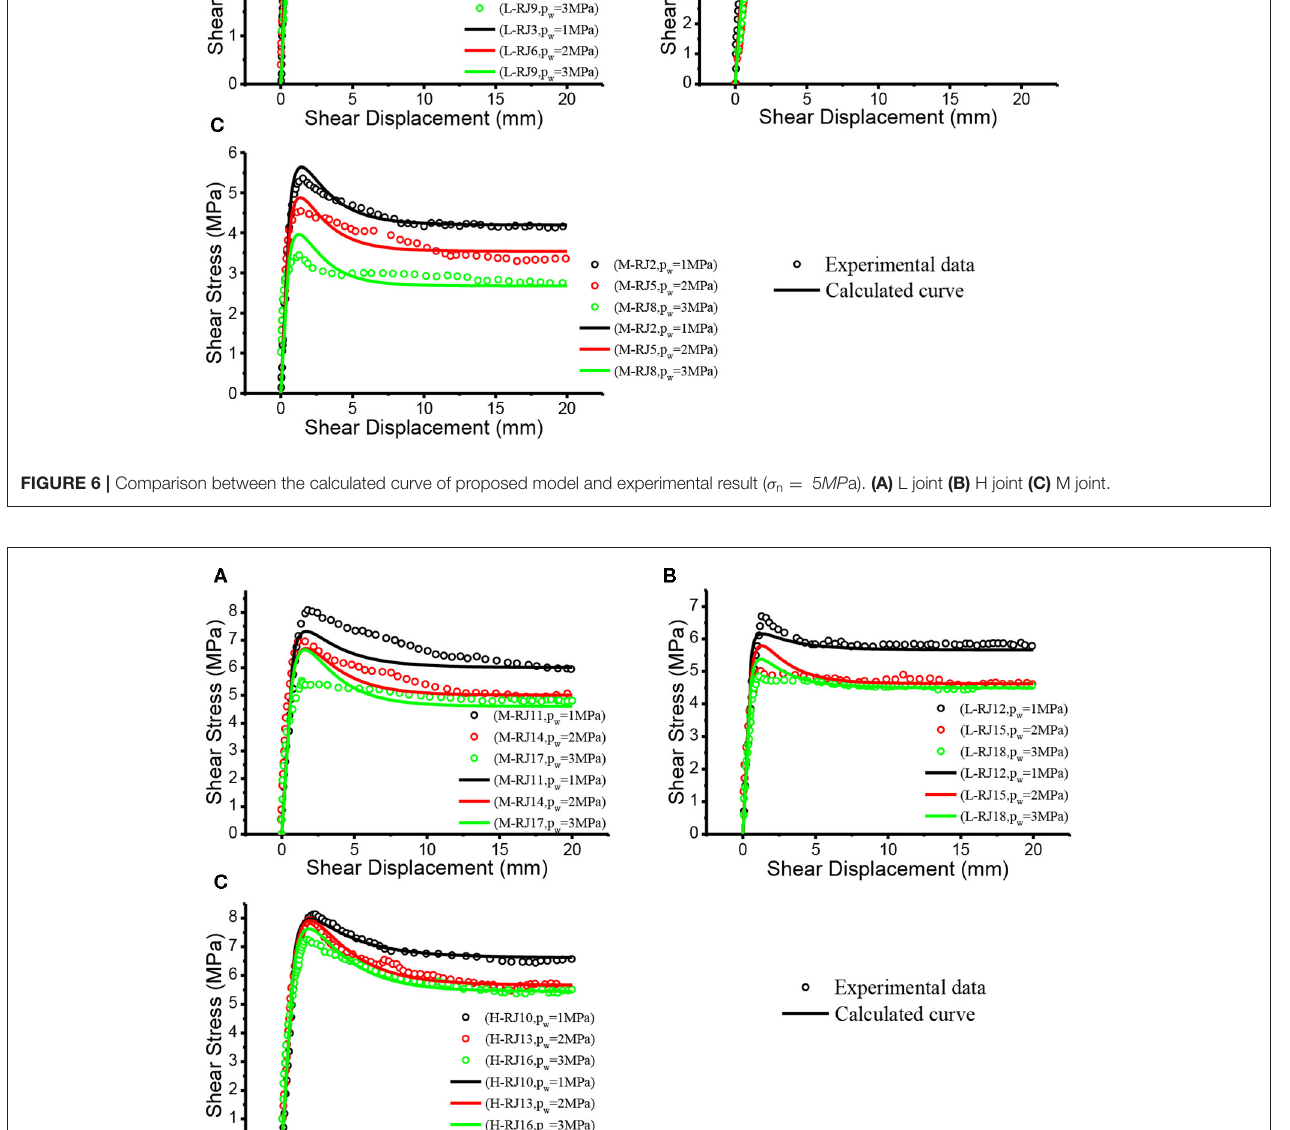
Frontiers in Earth Science |